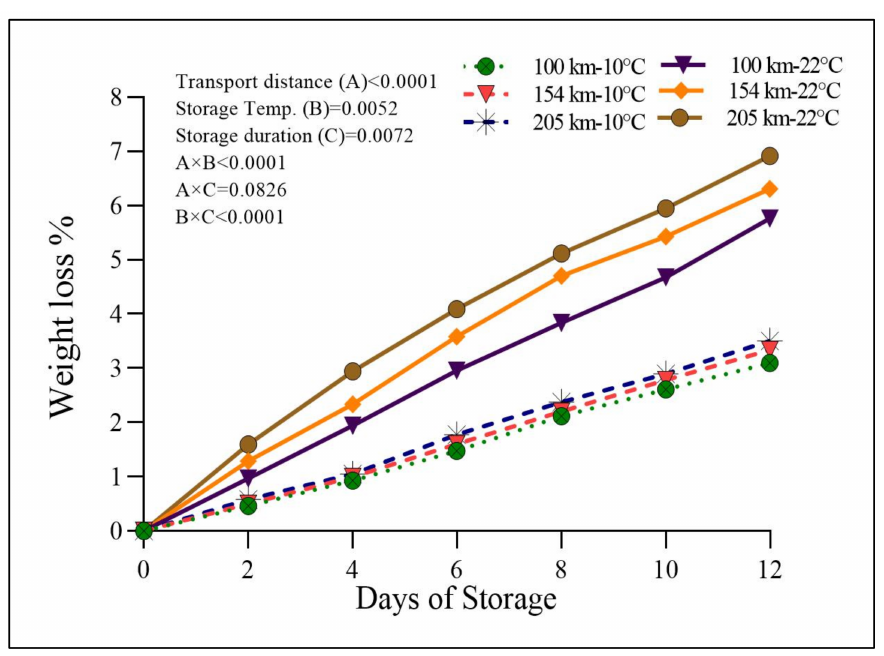
Figure 4. Weight loss (%) of tomatoes from three different distances stored at (A) 10 ± 0.5 ◦ C (95 ± 1%RH) and (B) 22 ± 1 ◦ C (65 ± 5%RH) for 12